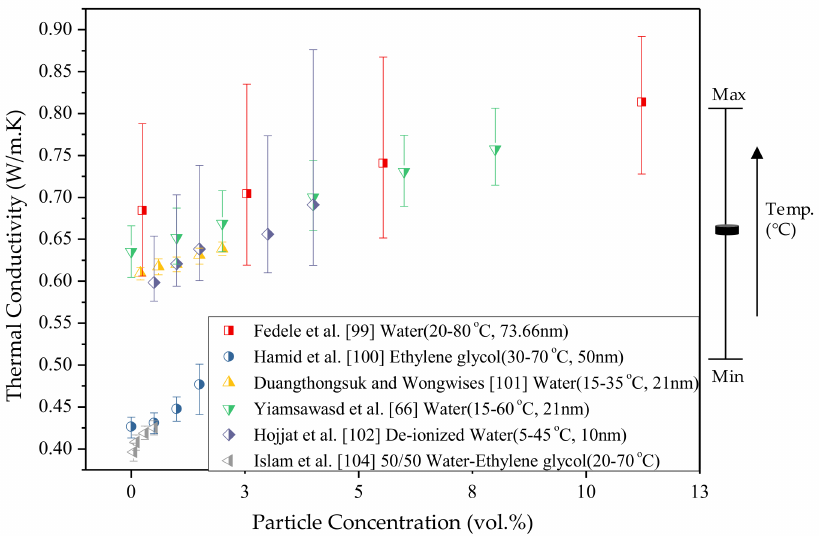
Figure 17. Thermal conductivity of TiO 2 nanofluid as a function of particle concentration (various